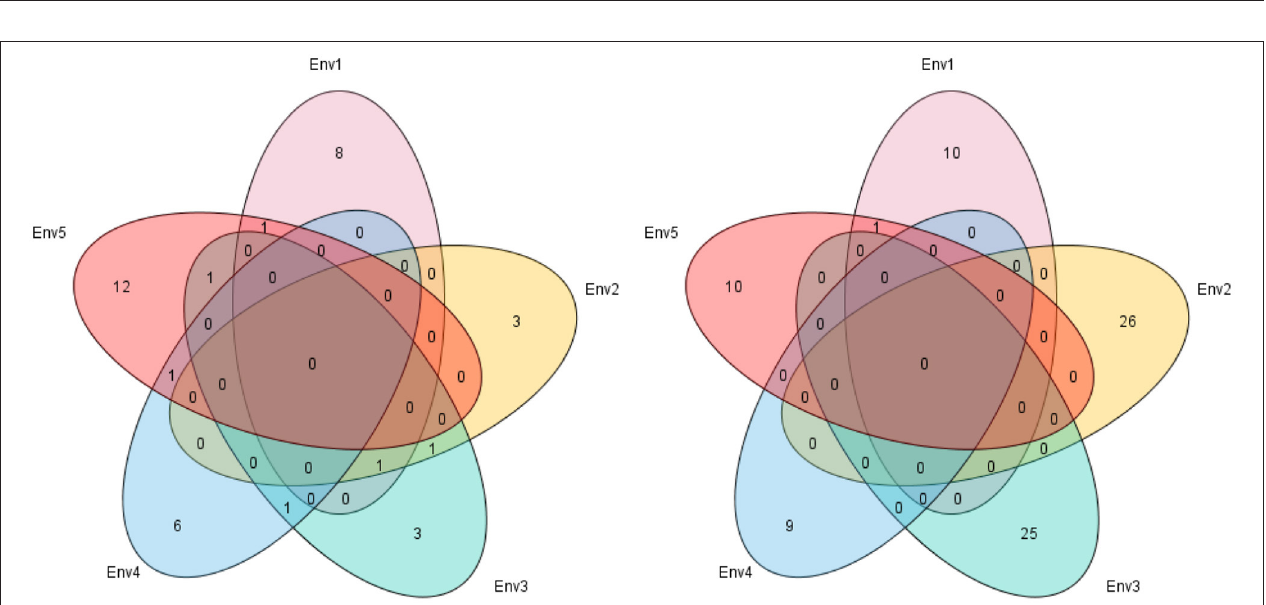
FIGURE 4 | Venn figure for frequency of linkage (left) and genome-wide association study (GWAS) (right) quantitative trail loci (QTL) underlying main stem node number (MSNN) and response to density increment. D1, normal density (2.2 × 10 5 plants/ha); D2, high density (3 × 10 5 plants/ha); RD, response to density.